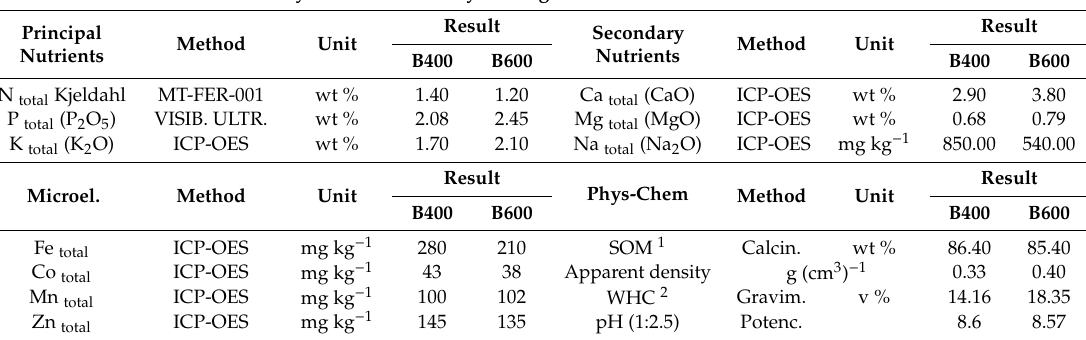
Table 2. Physicochemical analyses of biochar produced at two di ff erent temperatures (400 ◦ C—B400 and 600 ◦